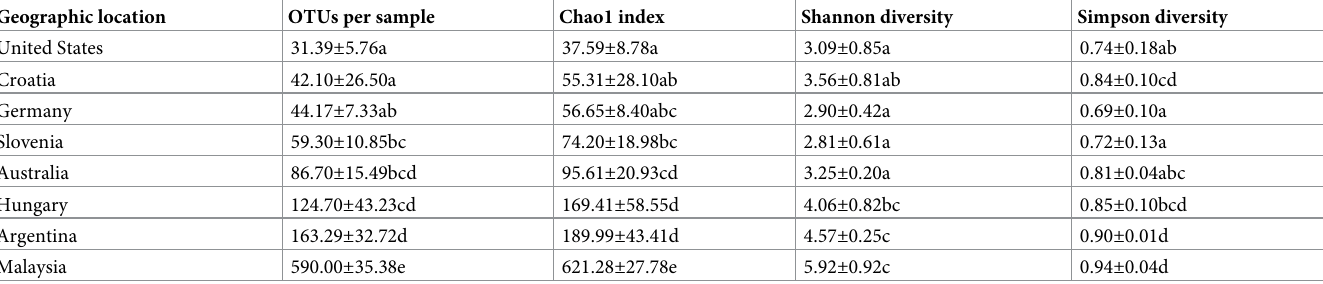
Mean ± SD are showing. Different letters indicate significant differences among samples according to Kruskal Wallis with Mann-Whitney post-hoc test ( P < 0.05) and Bonferroni